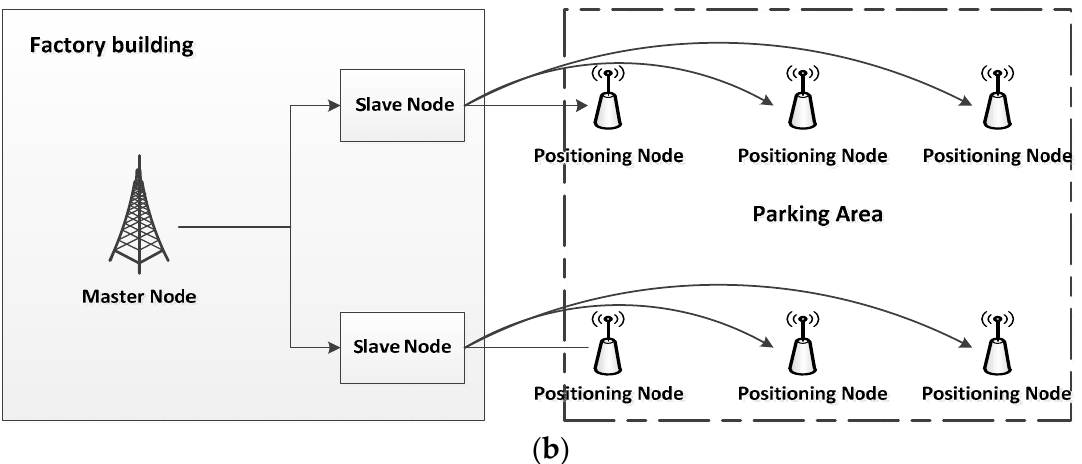
Figure 14. Parking management based on 5G high accuracy positioning. ( a ) Photo of the test site; ( b ) Deployment of 5G high accuracy positioning.